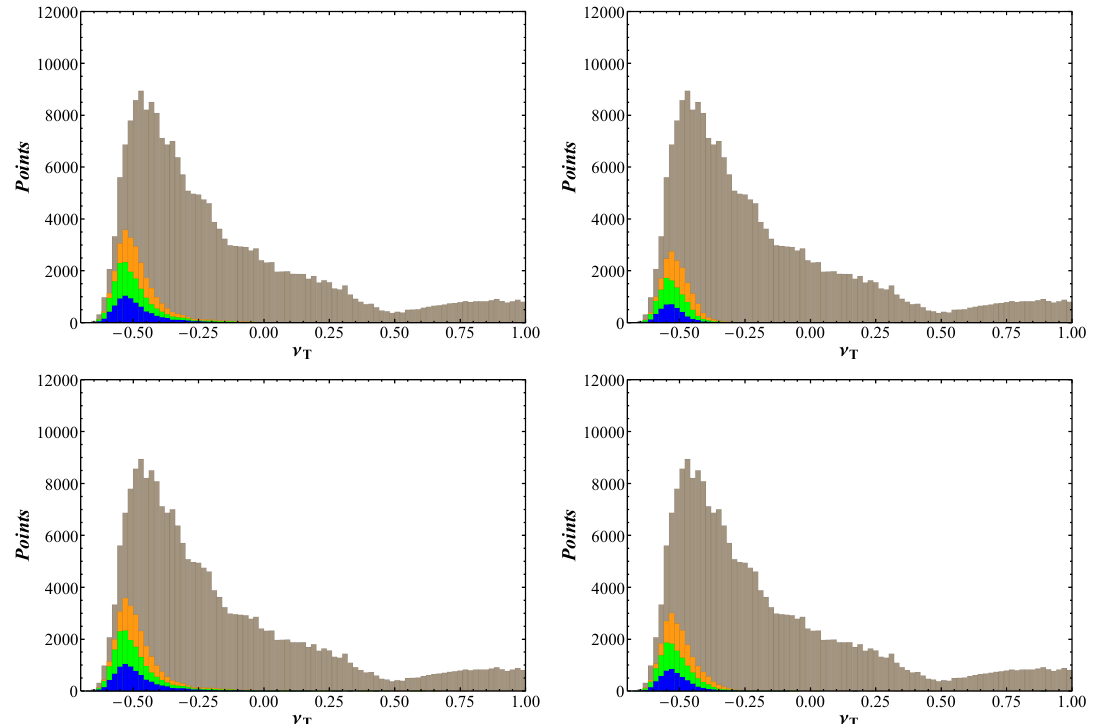
Figure 10. Histograms of the parameter (cid:23) T , for g A = g B = 0 : 1 and v F =k = 0 : 1 (top left), g A = g B = 1 : 0 and v F =k = 0 : 1 (top right), g A = g B = 0 : 1 and v F =k = 1 : 0 (bottom left), and g A = g B = 1 : 0 and v F =k = 1 : 0 (bottom right). The blue represents points which satisfy the 68% CL experimental limit in the h d (cid:0) (cid:27) d plane, the green represents the 95% CL region, the orange represents the 99.7% CL region, and the beige includes all points in our sample pool, with no h d (cid:0) (cid:27) d